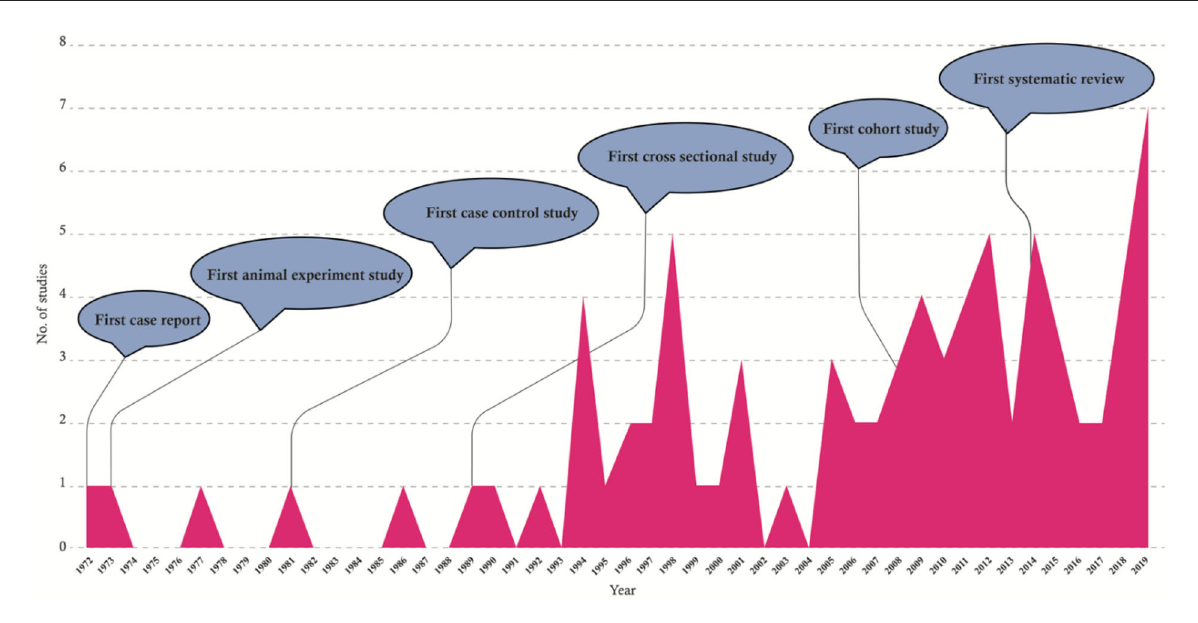
FIGURE4 Graphical presentation of the time trends of the studies published on the asthma- Toxocara association from 1972 to